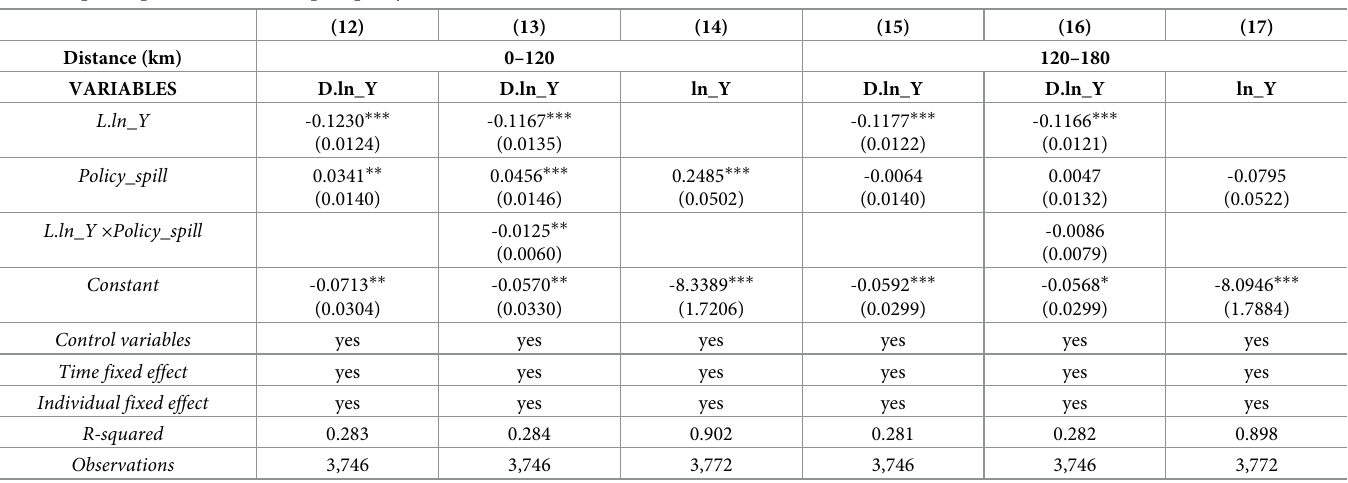
Table 5. Spatial spillover effect of the pilot policy (Plan